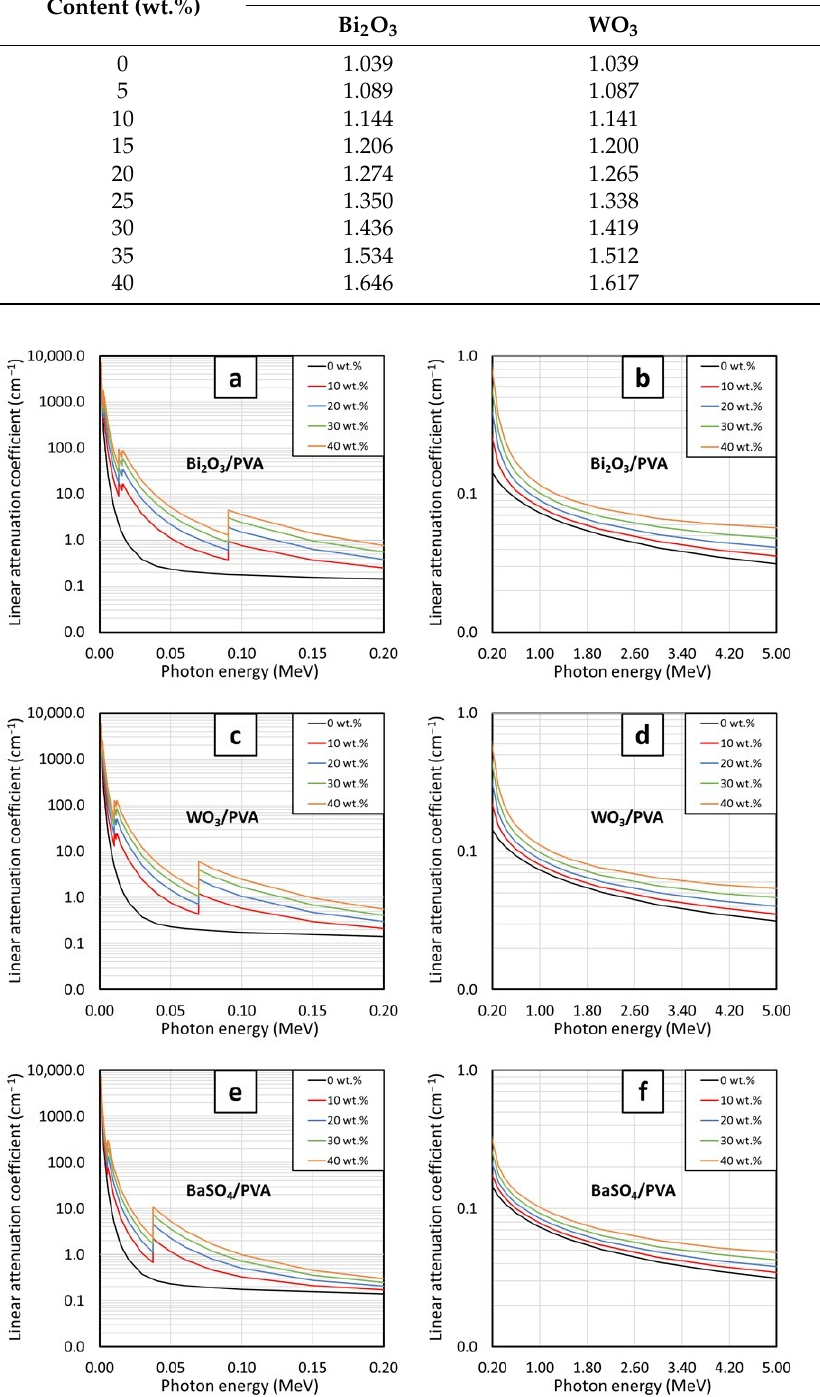
Figure 5. The µ values of ( a , b ) Bi 2 O 3 /PVA, ( c , d ) WO 3 /PVA, and ( e , f ) BaSO 4 /PVA hydrogels containing varying filler contents of 0, 10, 20, 30, and 40 wt.%, determined at photon energies of ( a , c , e ) 0.001–0.2 MeV and ( b , d , f ) 0.2–5 MeV using